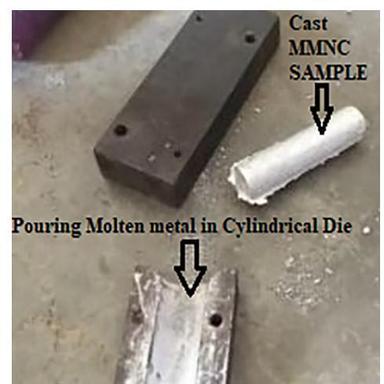
Pour Magnesium nano composite molten material in to Cylindrical.